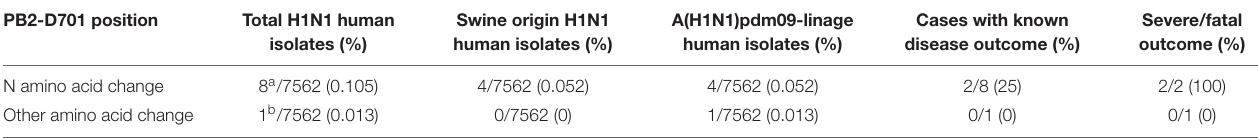
TABLE 2 | Prevalence, origin, and disease outcome data related to H1N1 viruses bearing changes at position 701 of influenza PB2 polymerase subunit. PB2-D701 position Total H1N1 human isolates